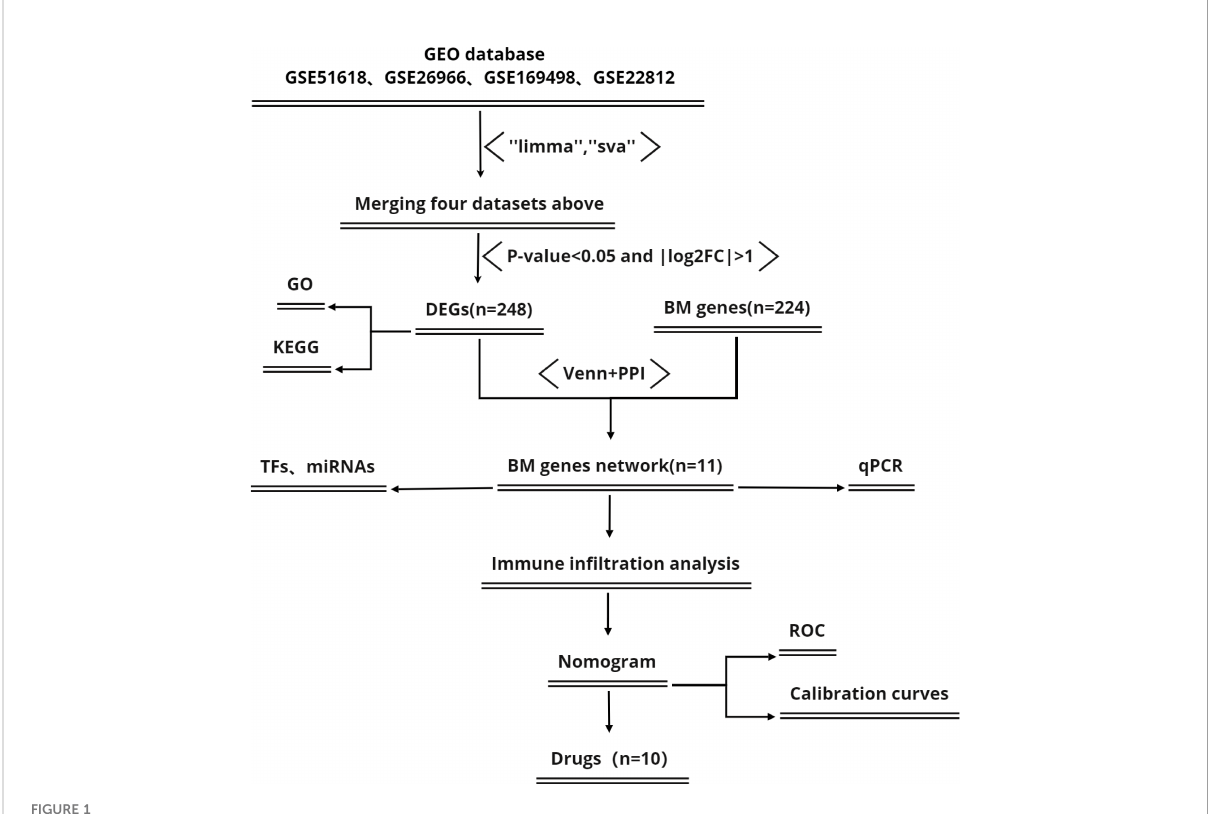
FIGURE 1 Flowchart showing the study